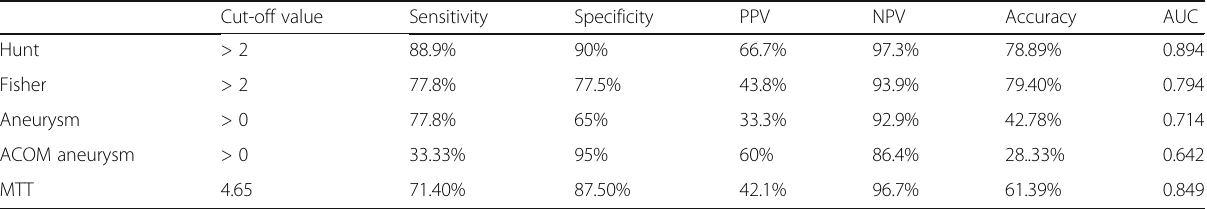
Table 4 Sensitivity, specificity, PPV, PPV, accuracy, and AUC of the potential